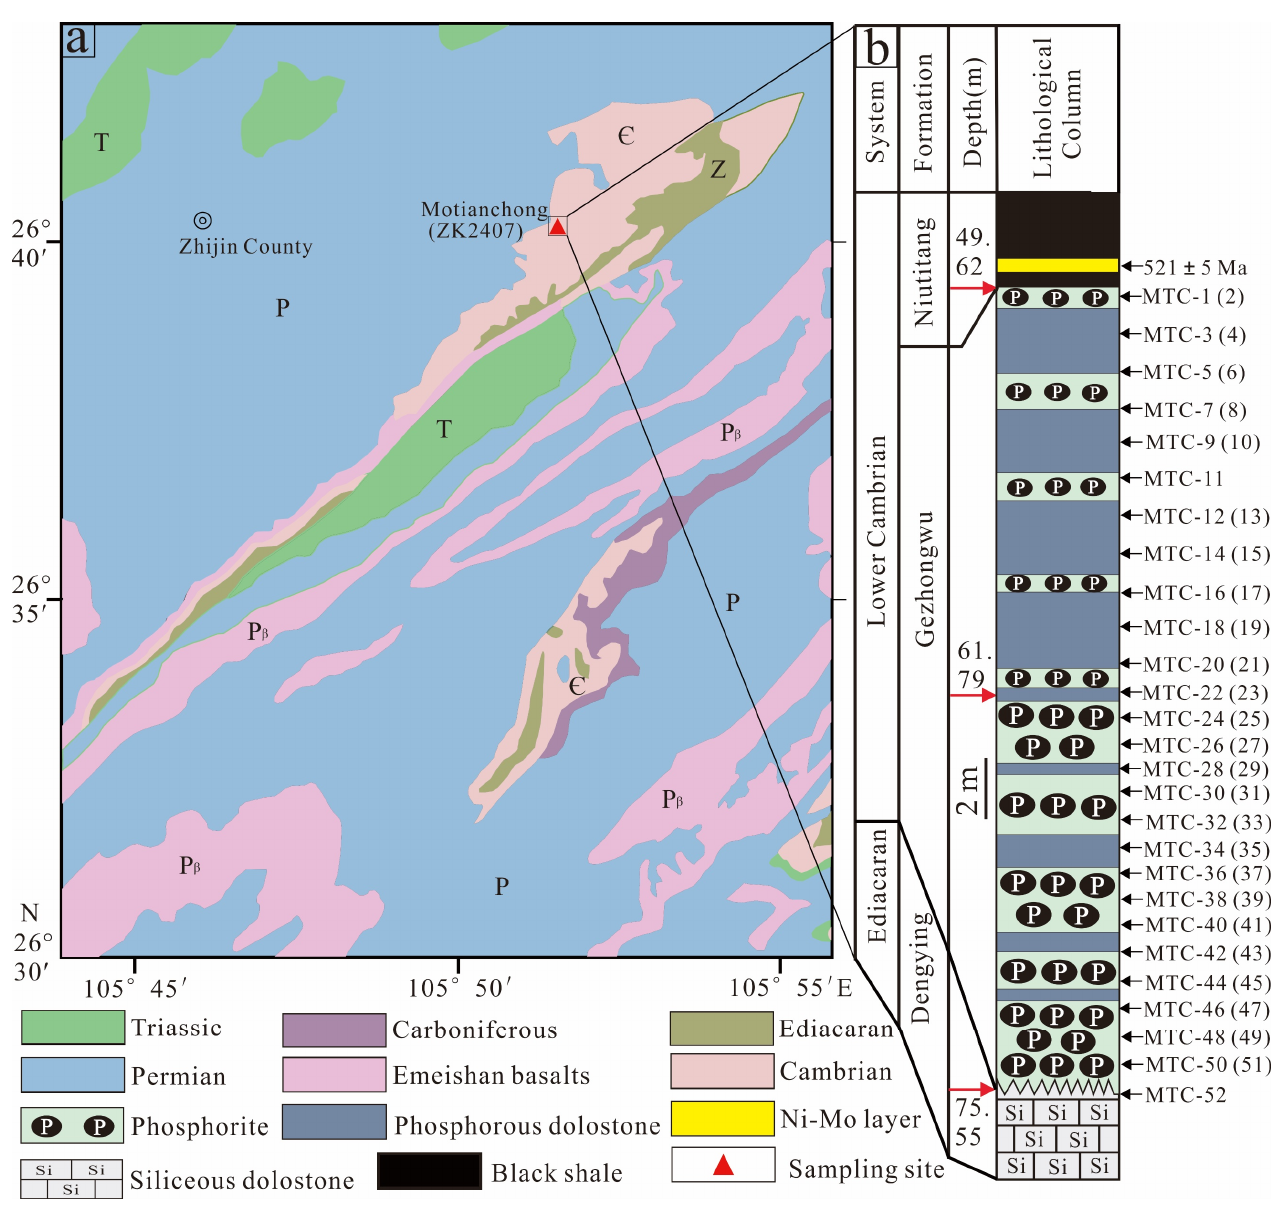
Figure 2. ( a ) Geological map of phosphorite deposits in the Motianchong (MTC) ore block; ( b ) stratigraphic column of ZK2407. The red triangle represents the sampling site. The age of Ni-Mo layer is from [42].